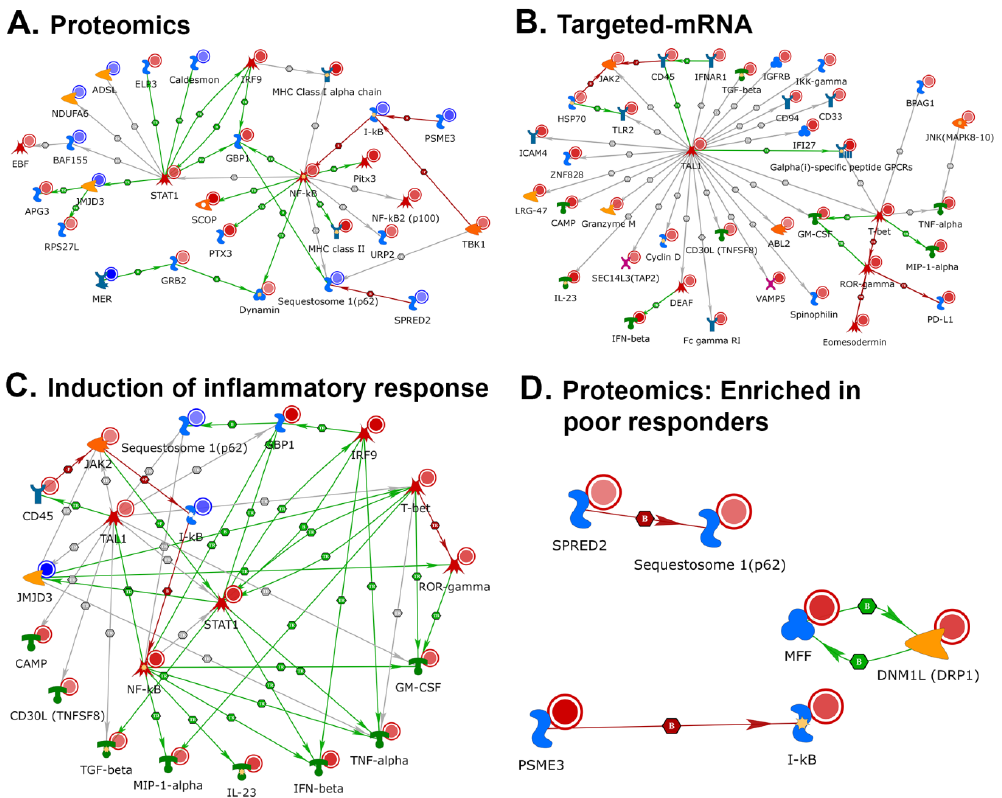
Figure 4. Network analysis of multi-omics data by MetaCore network building tool. ( A ) Proteomics data were analyzed for direct interactions among both upregulated and downregulated seed nodes.